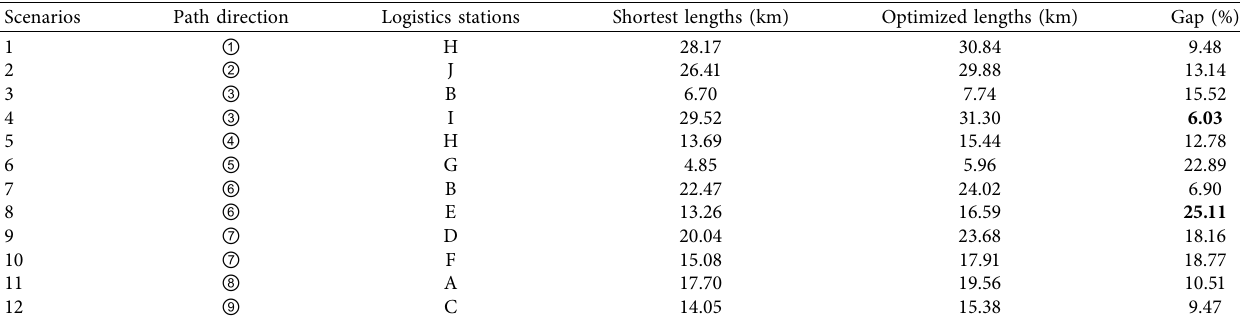
Figure 3: People’s travel time distribution in different types of areas on workday. Table 5: Truck path optimization results in off-peak hour.